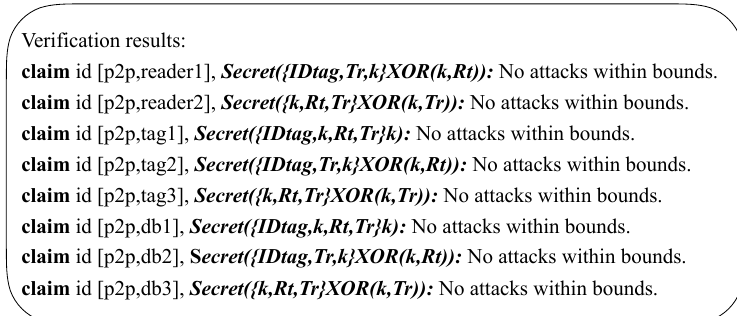
Figure 4. The result of UEAP protocol ’s security analysis with Scyther.